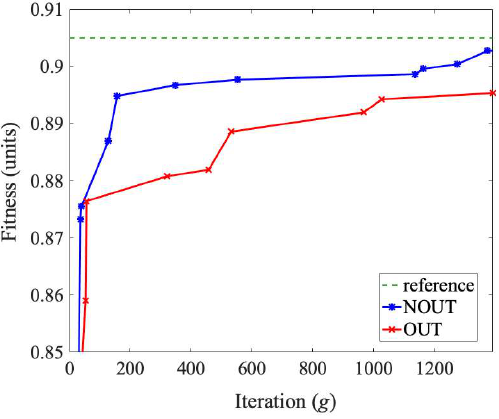
Figure 8. Fitness function improvements.